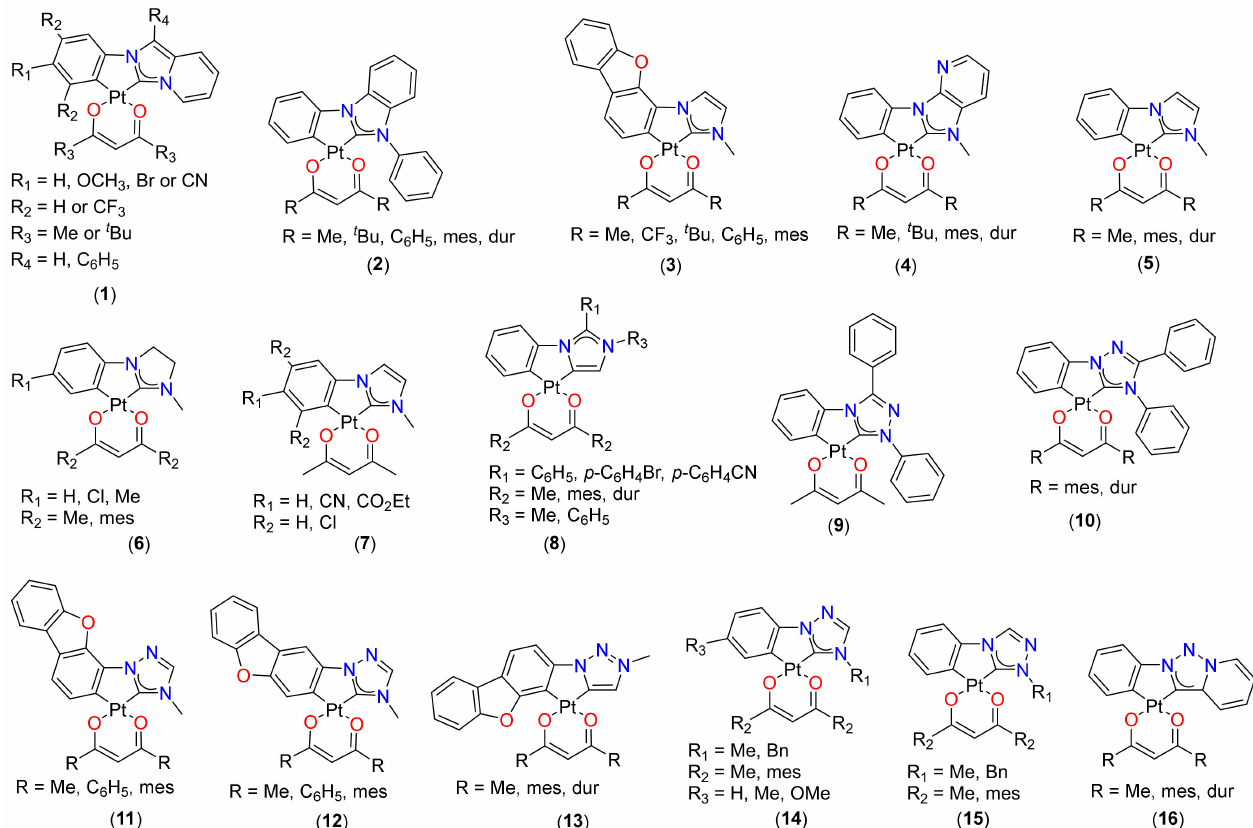
Figure 2. Pt(II) complexes based on imidazole, pyrazole, and triazole-derivatives based NHCs as the cyclometalating ligand and β -diketonate derivatives as ancillary